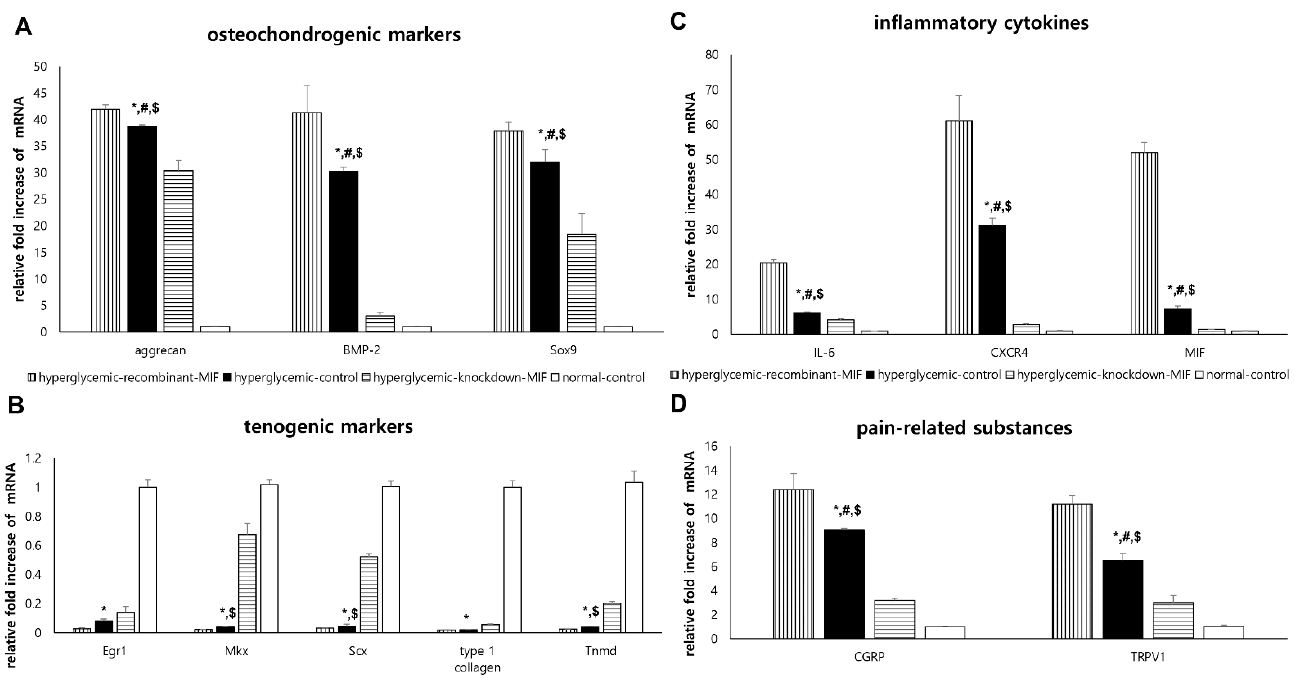
Figure 4. Effect of diabetic status and macrophage migration inhibitory factor (MIF) on TdSCs in vitro. Comparative analysis of mRNA expression levels of ( A ) osteochondrogenic differentiation markers (aggrecan, bone morphogenic protein (BMP)-2, and Sox9), ( B ) tenogenic differentiation markers (Egr1, Mkx, Scx, type 1 collagen, and Tnmd), ( C ) inflammatory cytokines (IL-6, CXCR4, and MIF), and ( D ) pain-related substances (CGRP and TRPV1) in TdSCs. The mRNA expression levels of the target genes were normalized to that of the GAPDH gene. *: statistical significance between the hyperglycemic-control and normal-control groups; # : statistical significance between the hyperglycemic-control and hyperglycemic-recombinant-MIF groups; $ : statistical significance between the hyperglycemic-control and hyperglycemic-knockdown-MIF groups.